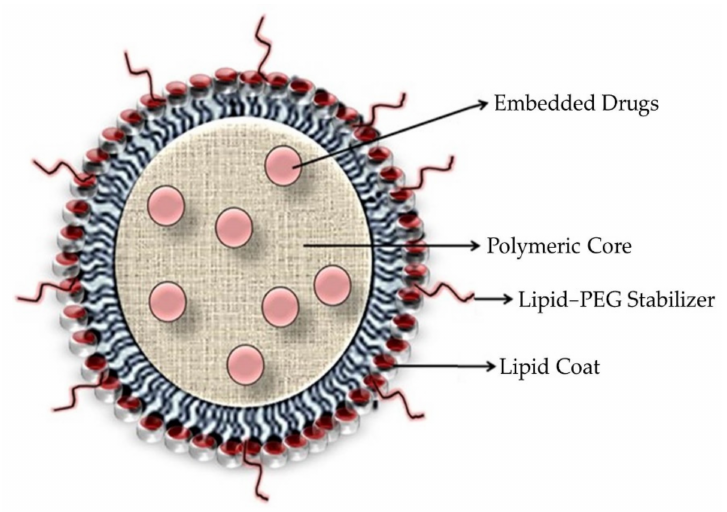
Figure 8. Diagrammatic representation of drug-loaded polymeric lipid hybrid